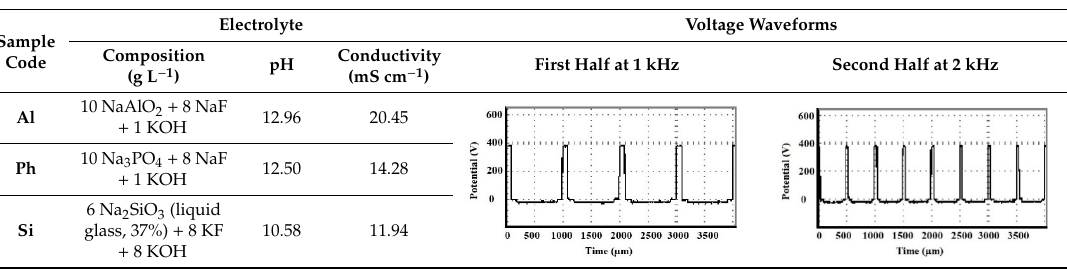
Table 1. Electrolytes variables, respective sample codes, and electrical parameters employed for the coating